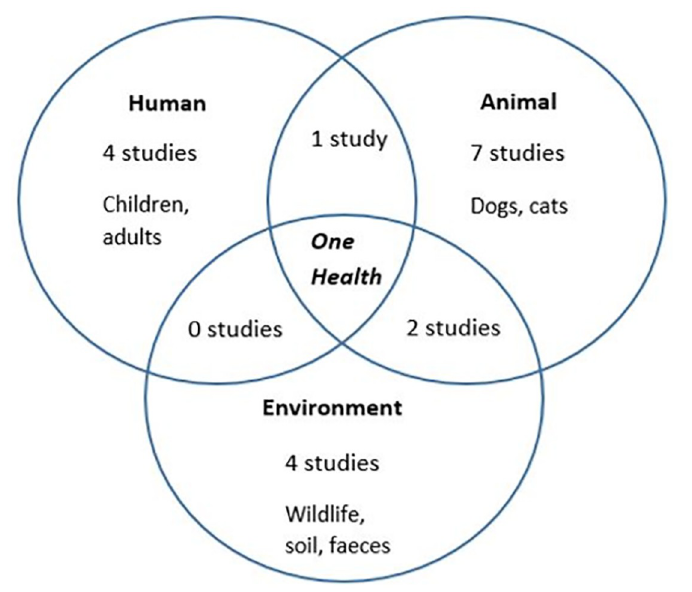
Fig 3. One health sector and species investigated in the evidence